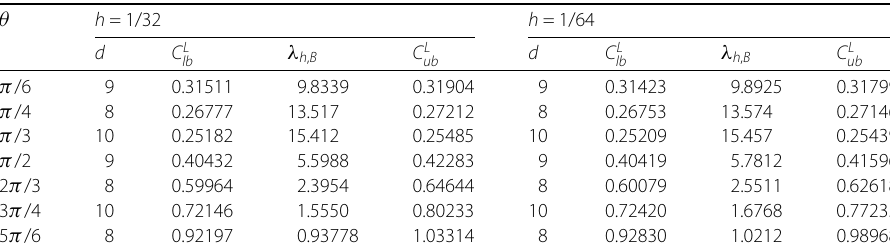
Table 2 The lower and upper bounds of C L (1, θ ) for triangles of different shapes